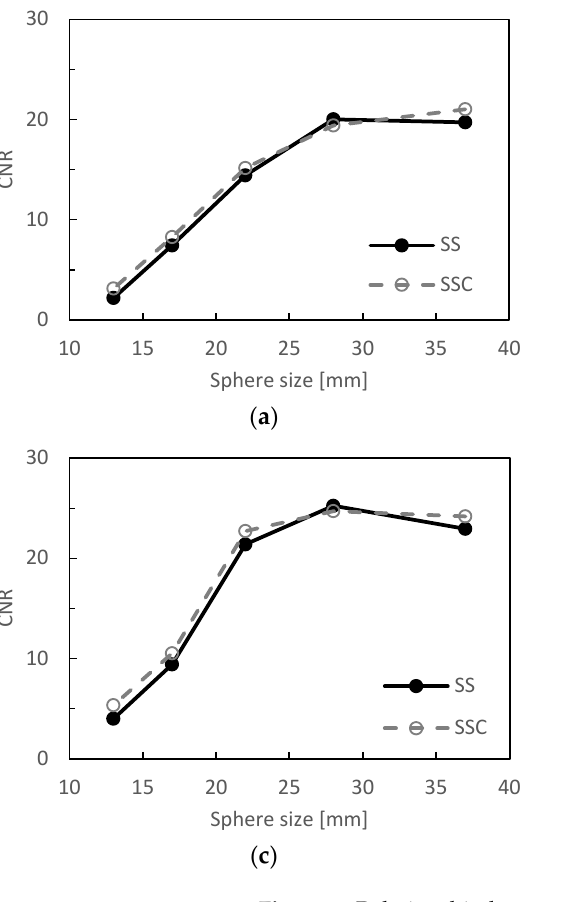
Figure 3. Relationship between CNR and hot sphere size for scan modes and correction methods: